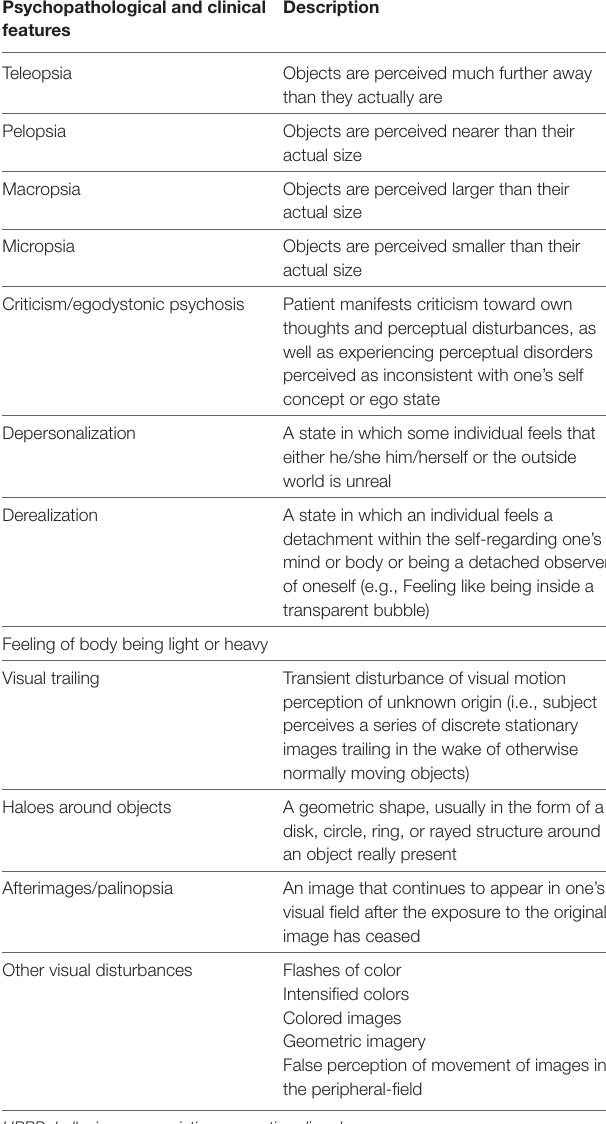
TAble 1 | Main clinical and psychopathological characteristics in